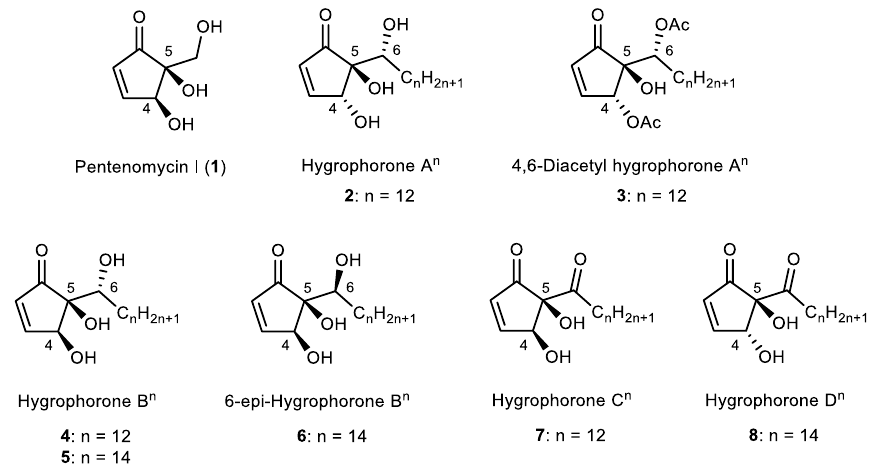
Figure 1. Chemical structures of pentenomycin I and representative